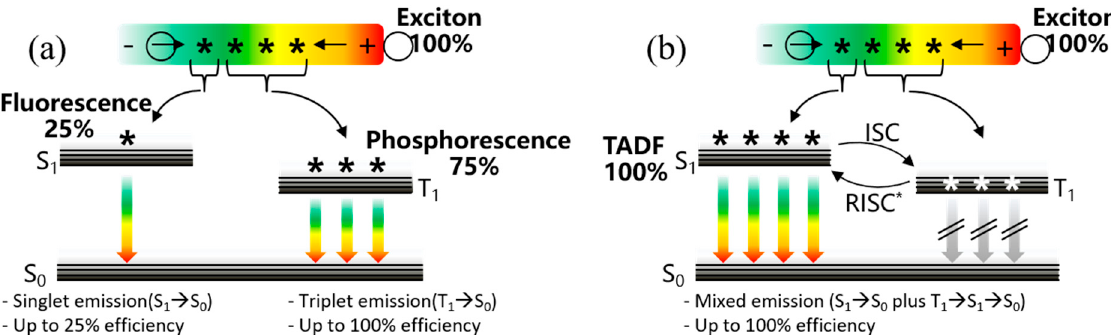
Figure 1. Energy diagram of ( a ) phosphorescent emitter and ( b ) TADF emi tt er.